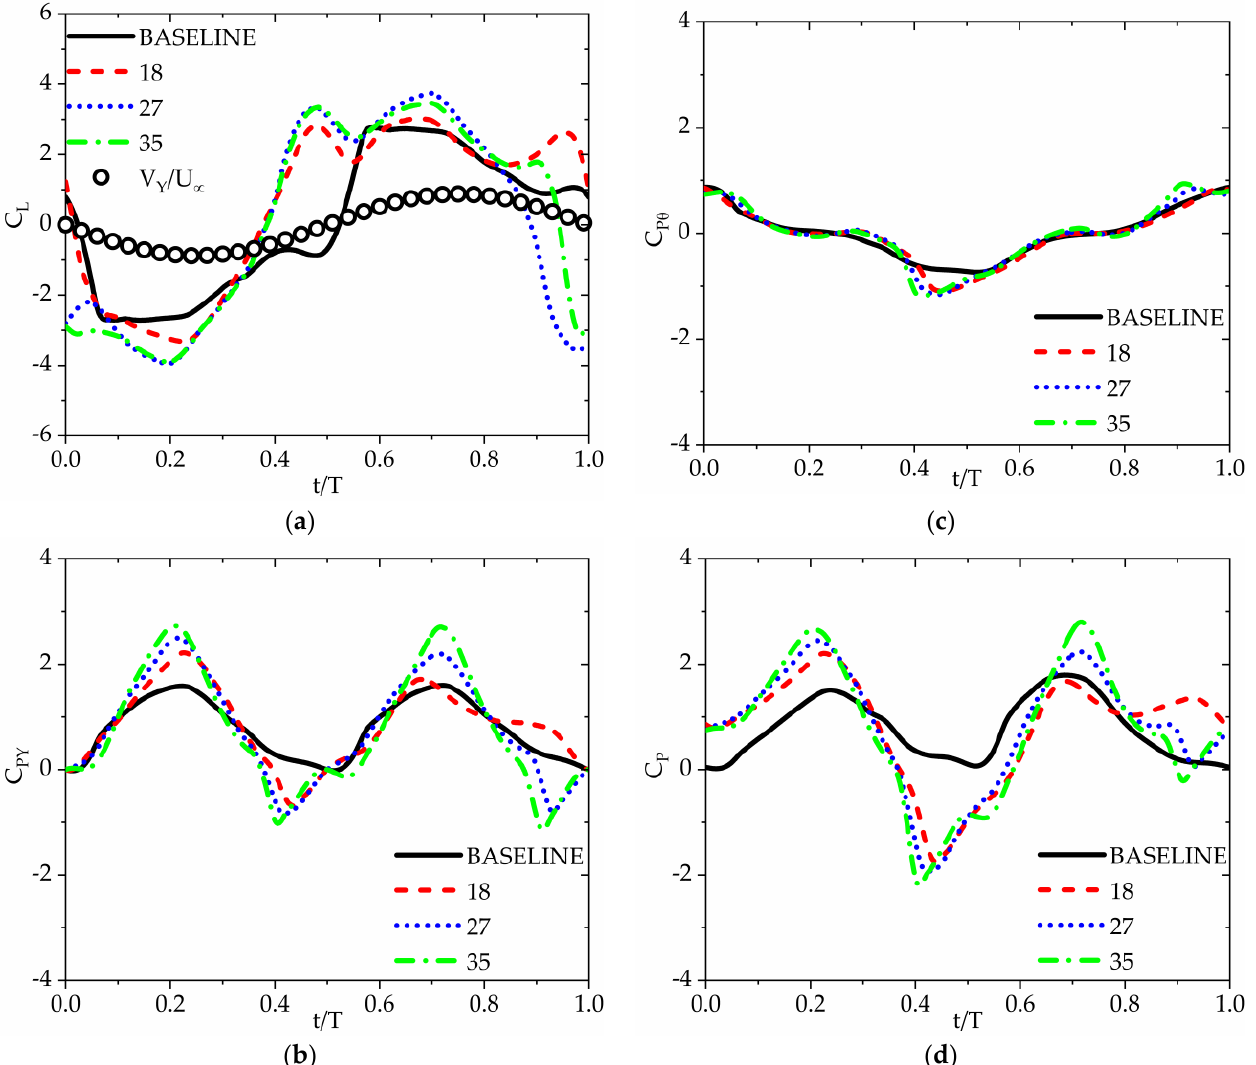
Figure 8. A comparison of the instantaneous lift and power coefficients of an oscillating hydrofoil equipped with a single/dual upstream deflector. ( a ) Lift coefficient. ( b ) Heave power coefficient. ( c ) Pitch power coefficient. ( d ) Net power coefficient.